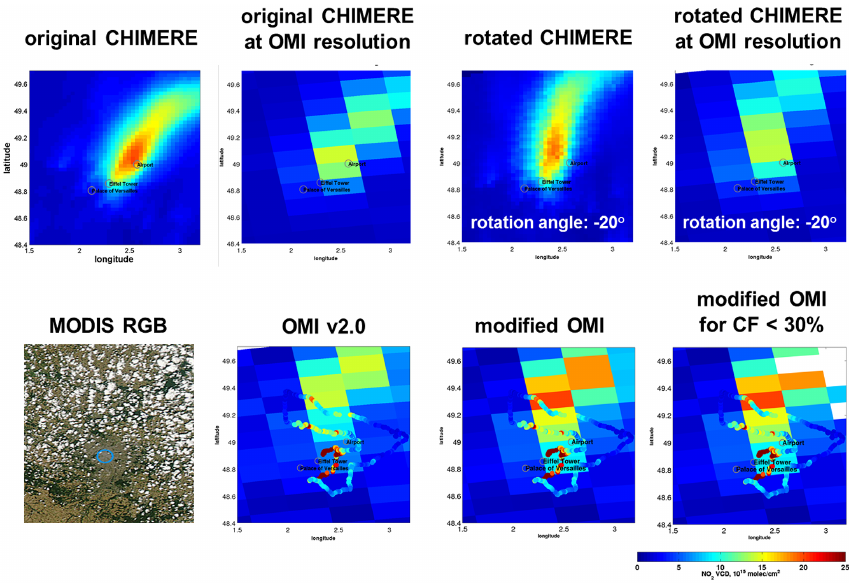
Figure 15. Comparison of different versions of OMI and CHIMERE data for 28 July 2009. Also shown are a MODIS RGB image and the car-MAX-DOAS results of that day.